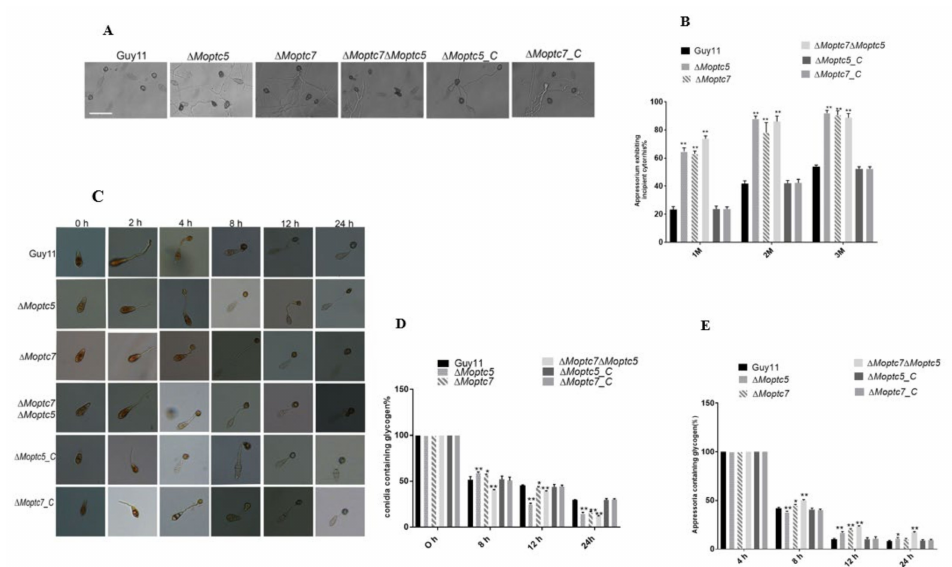
Figure 8. Deletion of MoPTC5 and MoPTC7 delayed glycogen mobilization from conidia to appres- soria and reduced appressorium turgor pressure. ( A , B ) represent the percentages of appressorium exhibiting incipient cytorryhsis after being treated with glycerol. ( C ) Mobilization of glycogen in the mutants and Guy11 at different time points. ( D , E ) Micrographs showing percentage of conidia and appressoria containing